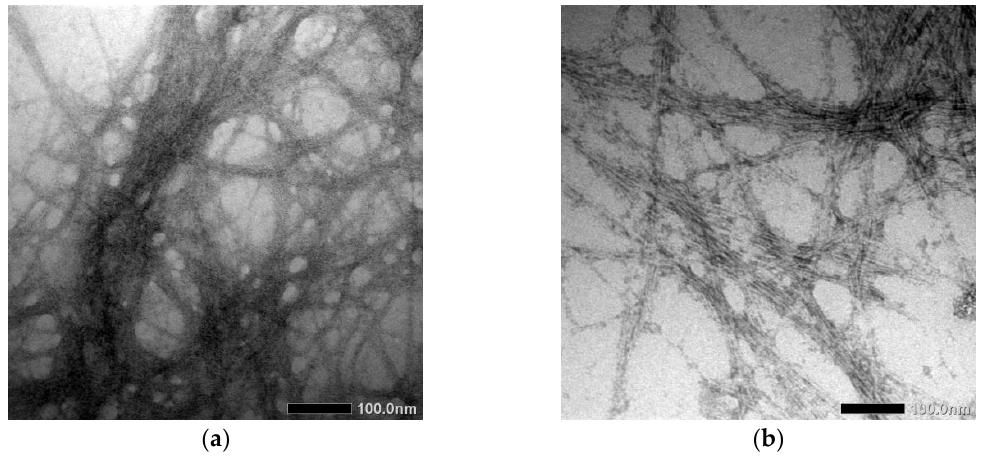
Figure 7. TEM image of ( a ) CNF procedure I and ( b ) CNF procedure II.